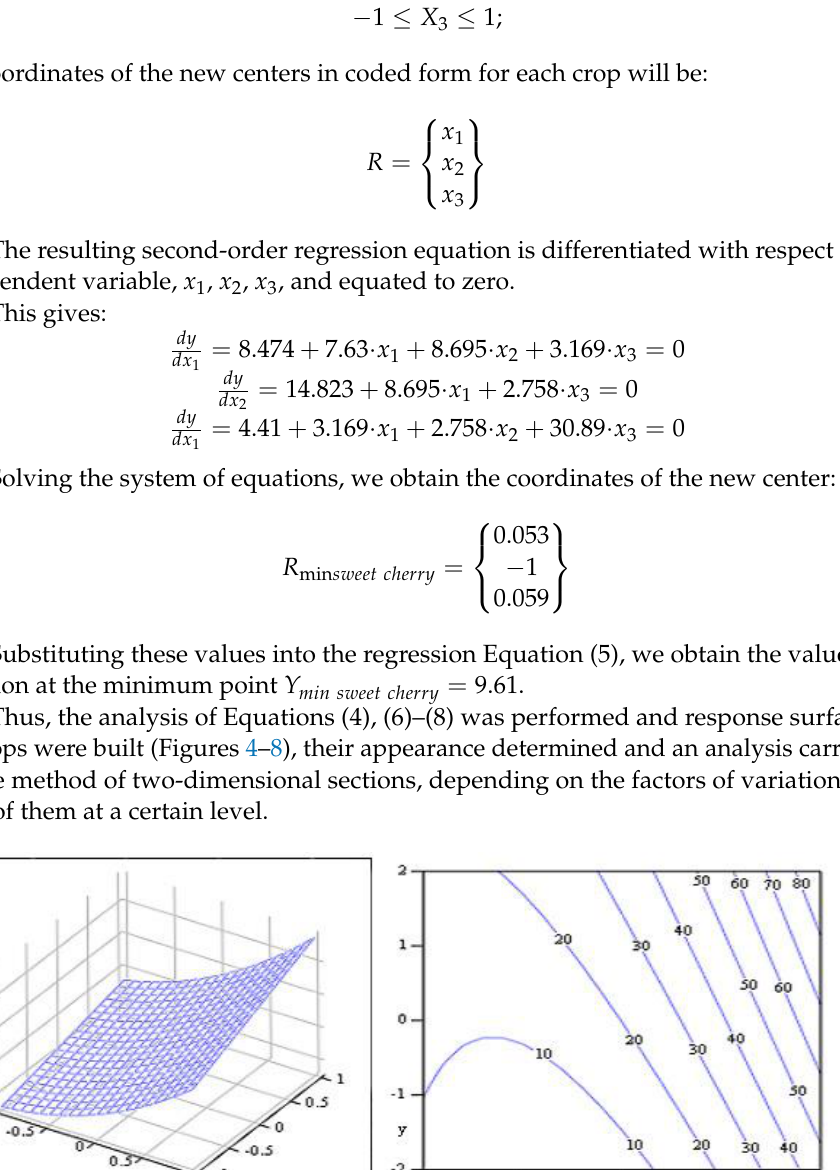
Figure 5. Graph and contour curves of the dependence of criteria Y on the factors х 1 , х 3 for cherries, when х 2 = 0. Figure 6. The graph and contour curves of the dependence of criteria Y on the factors х 1 , х 3 for cherries, when х 2 = 0. Figure 7. Graph and contour curves of the dependence factors of criterion Y on factors х 2 , х 3 for apricot, when х 1 = 0.